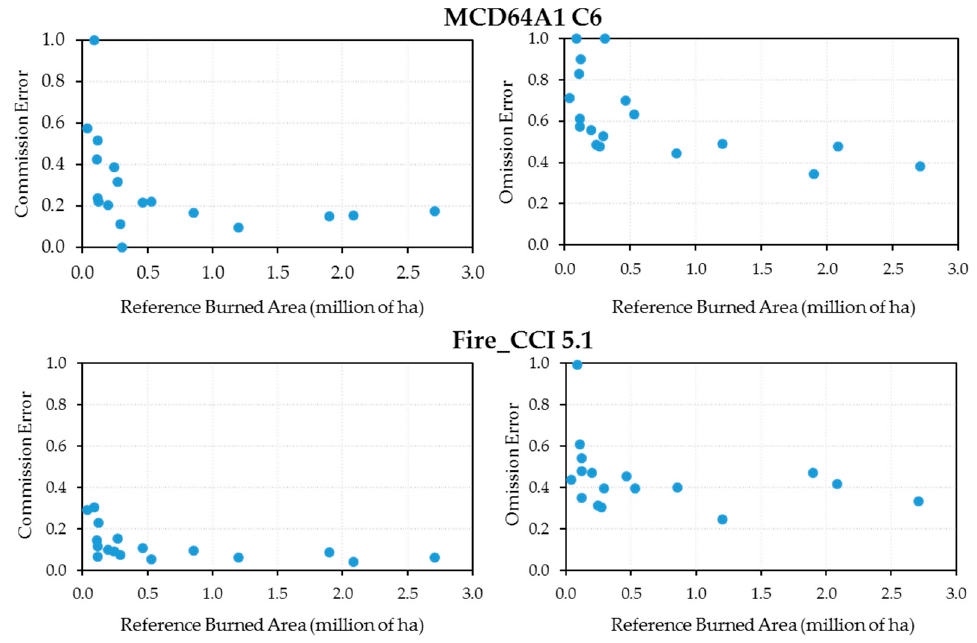
Figure 10. Scatterplot for the annual commission and omission errors versus the annual reference burned area.